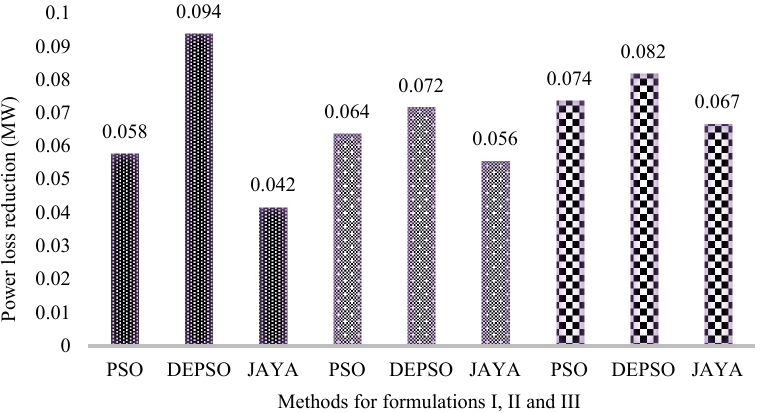
Figure 8. Power loss reduction for IEEE 118-bus system.